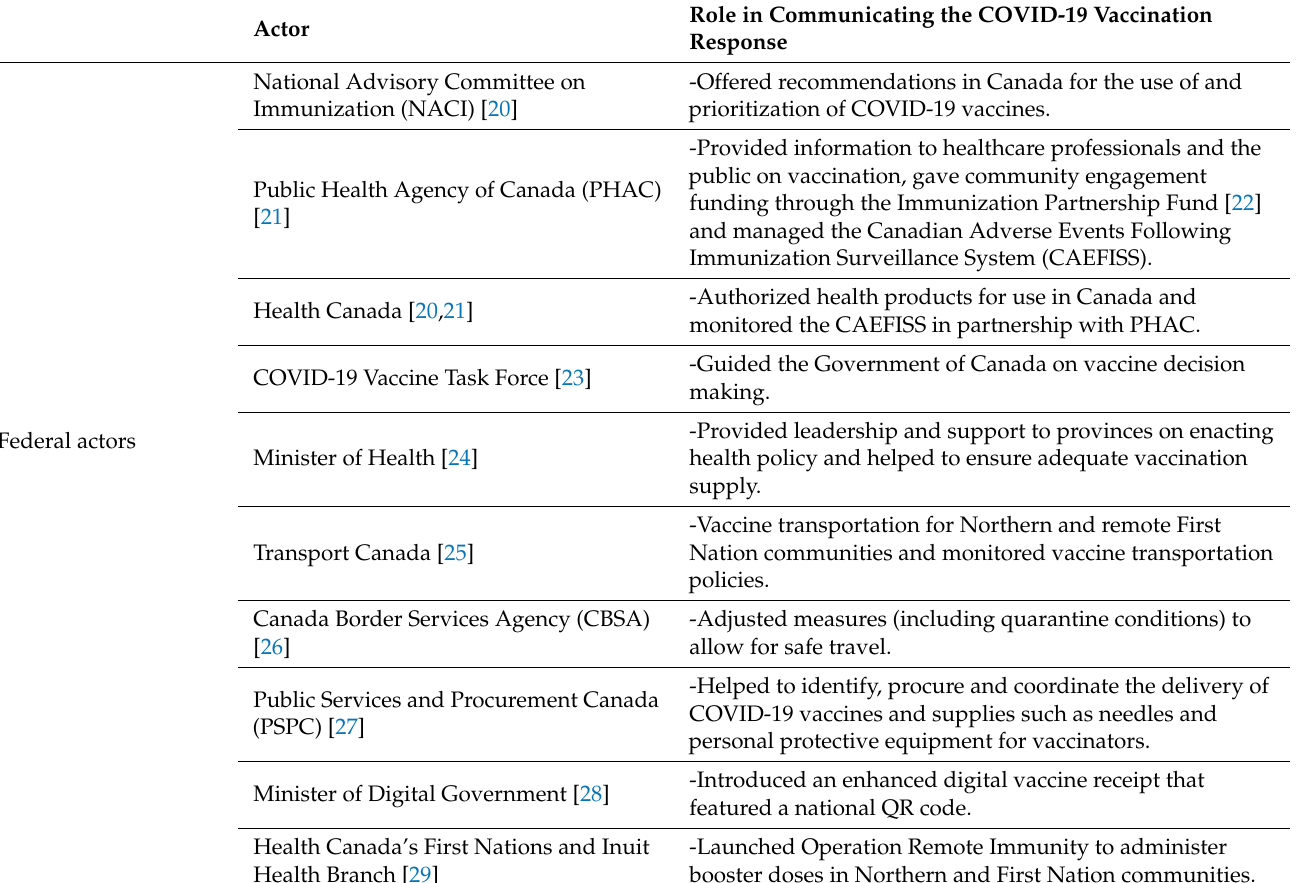
Table 1. Roles of actors in the Canada pandemic response.